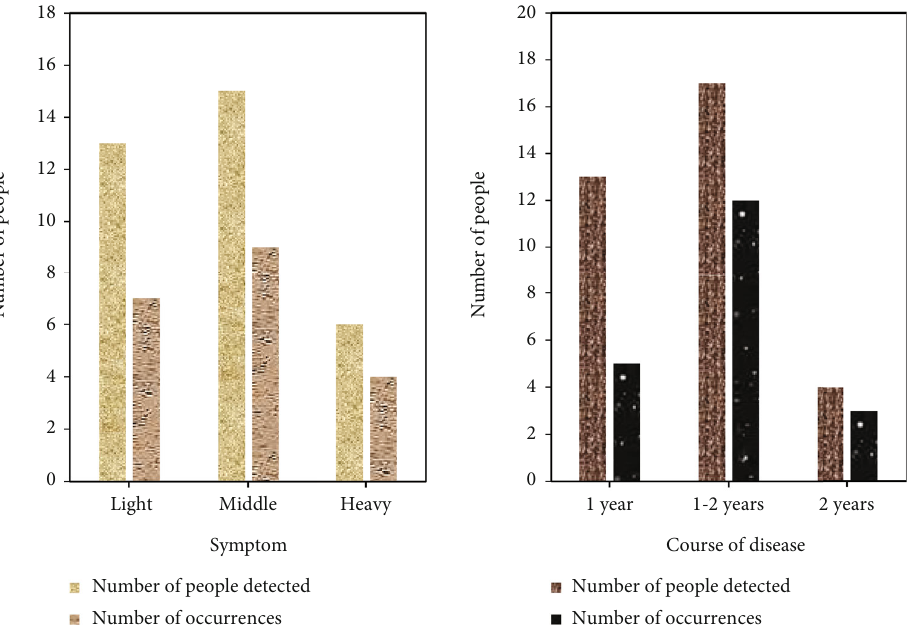
Figure 9: Comparison of positive detection rates of SCL in patients with chronic prostatitis under di ff erent